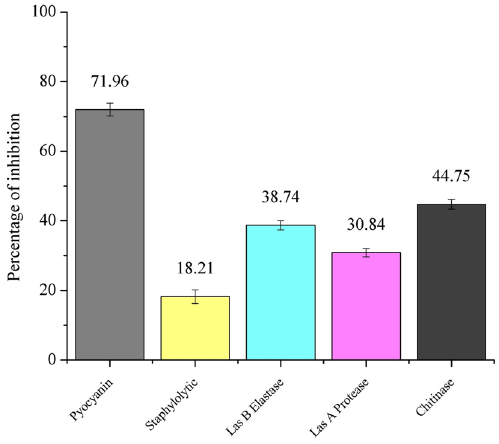
Fig. 1. Effect of sub-MIC dose (500 µg/ml) of P. tenuiflorus extract on production of QS regulated virulence factors such as pyocyanin, Staphylolytic activity, LasB elastase, LasA protease and chitinase activity